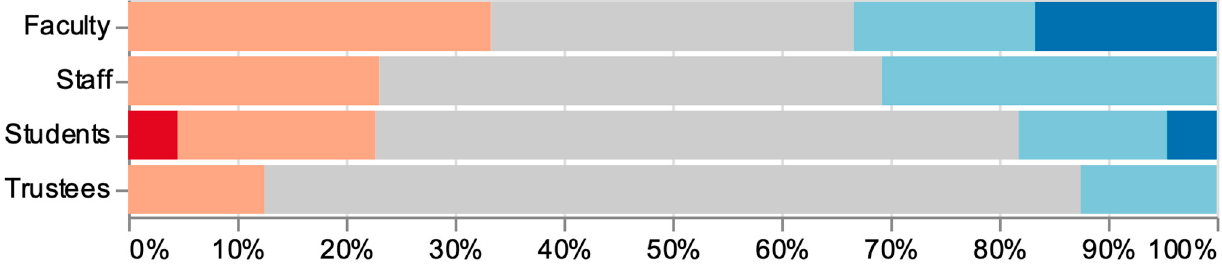
Figure 7. “I believe Lancaster Seminary already does a good job catering to the needs of bivocational students through academic curriculum.” (Q14). 2% strongly disagree; 22% disagree; 53% neutral; 18% agree; 5% strongly agree.